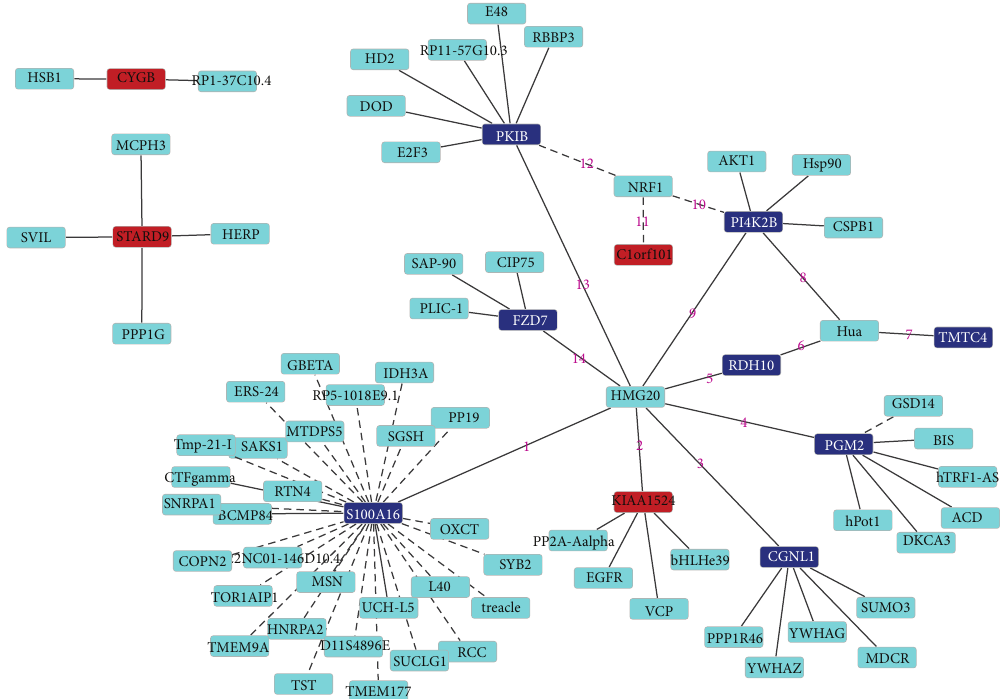
Figure 2: The constructed PPI network for the top 10 up- and downregulated DEGs. Nodes represent proteins; edges represent interactions between two proteins. Red- and blue-color nodes represent products of up- and downregulated DEGs, respectively. Green nodes denote products of genes predicted to interact with the